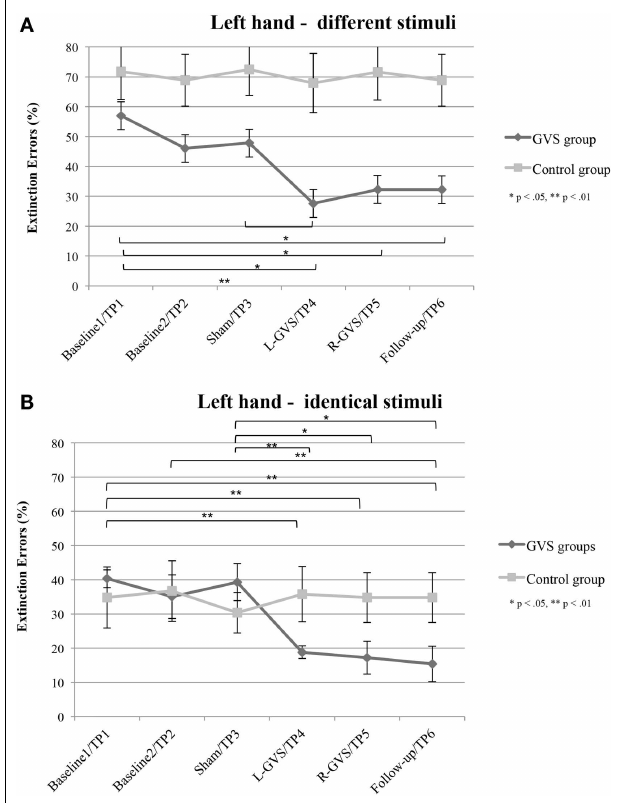
FIGURE 3 | Mean ( ± standard error of the mean) extinction errors (%) for the left hand in the Quality ExtinctionTest (QET) of the GVS group ( N = 6) and control group ( N = 6) across the six measurement sessions for application of different tactile stimuli (A) and of identical tactile stimuli (B). Note that apart from moderate variations in error rates no significant improvement was observed in the control group due to retesting in six subsequent sessions. Abbreviations: see legend of Figure 2 .